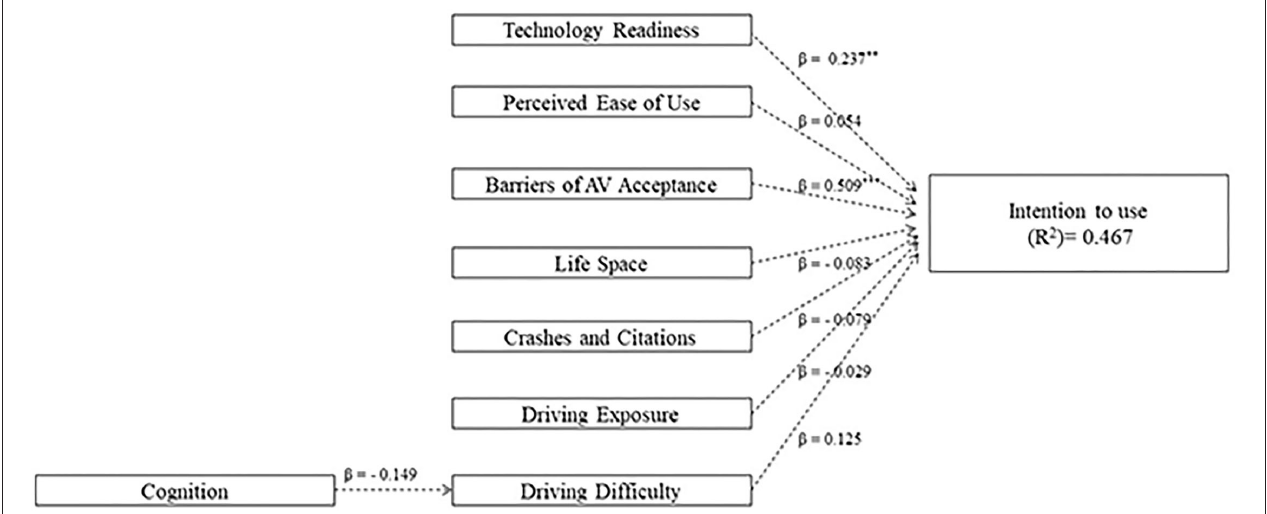
FIGURE 2 | Bootstrapped pathway analysis predicting older adults’ intention to use the technology.